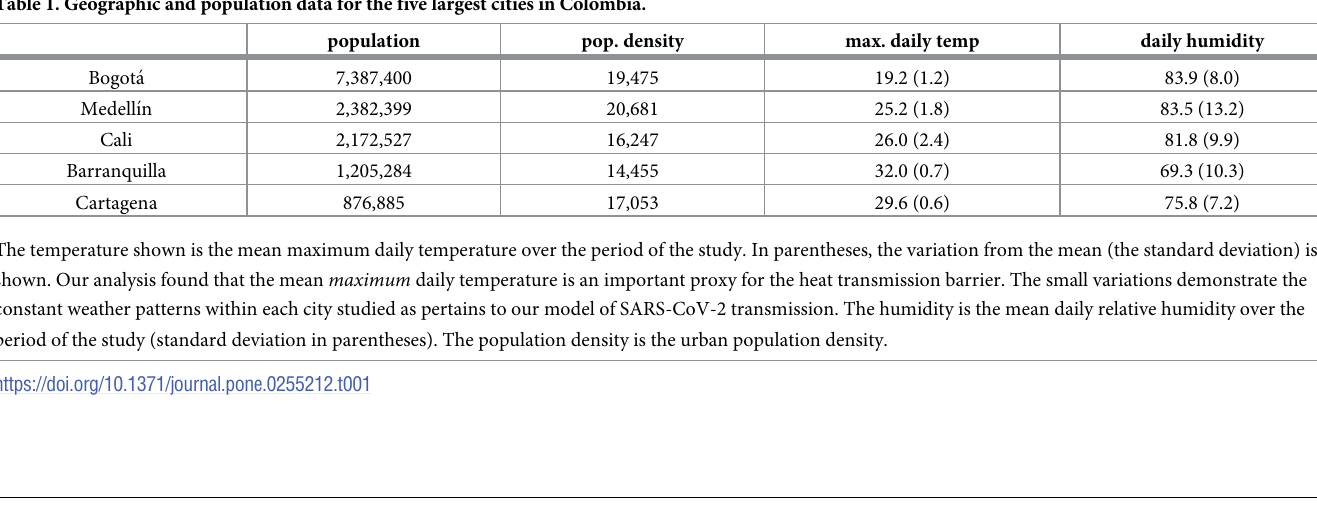
Table 1. Geographic and population data for the five largest cities in Colombia. population pop. density